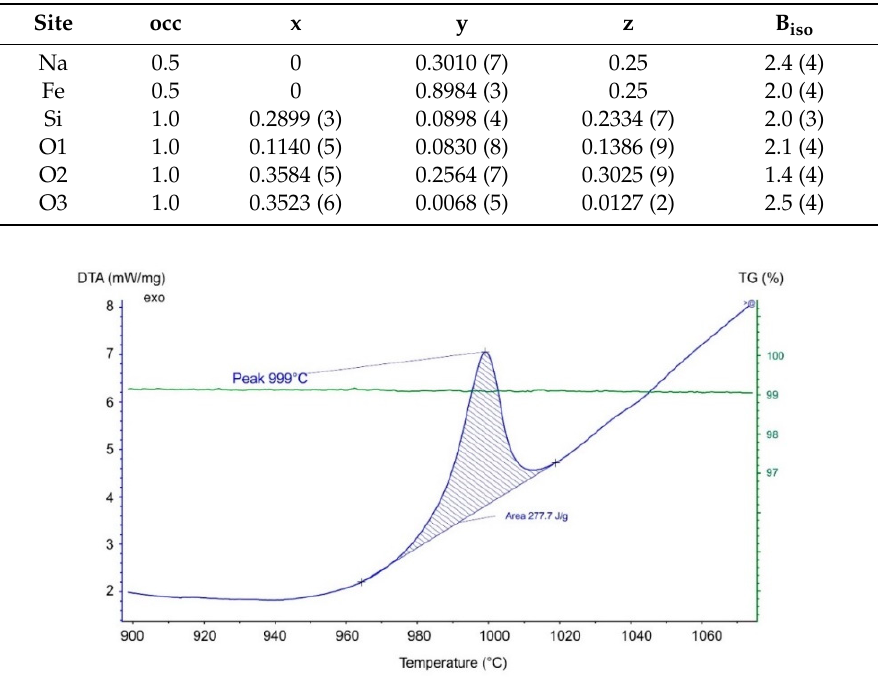
Table A2. Fractional atomic coordinates and isotropic atomic displacement parameters for aegirine, obtained at 200 °C and annealed at 900 °C for 24 h, as determined from Rietveld refinement of powder X-ray diffraction data (R exp = 5.90%. R wp = 6.5%, R p = 5.02% Goodness of Fit = 1.10).